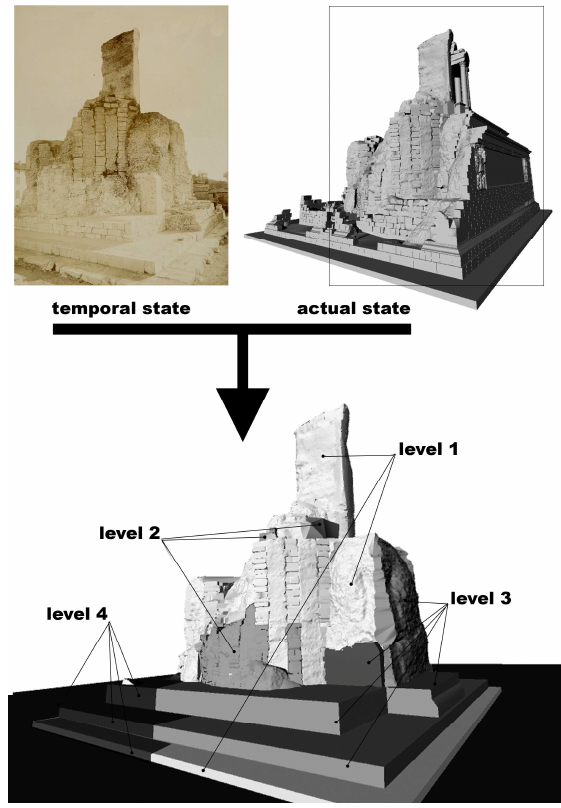
Figure 10. Uncertainty visual coding for the hypothetical representation of a temporal